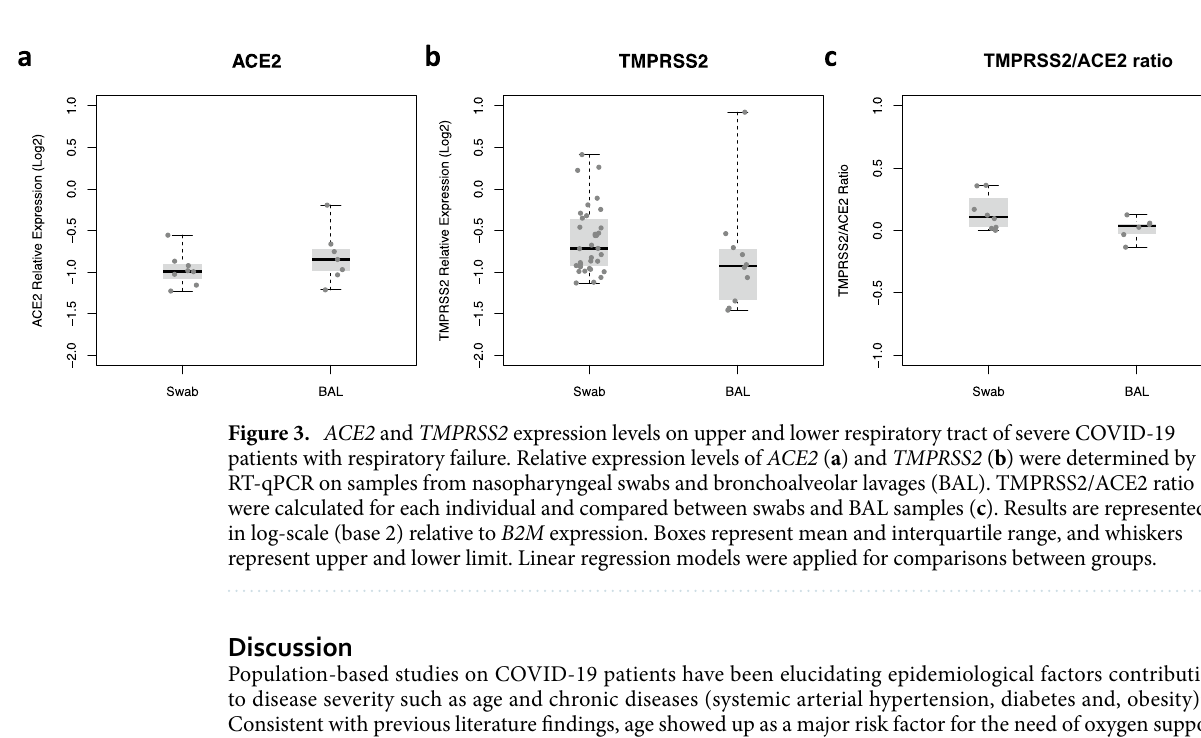
Table 2. Association between ACE2 and TMPRSS2 expression on nasopharynx and respiratory distress during COVID-19. *OR estimates adjusted for age, systemic arterial hypertension, diabetes and obesity. OR values represent an associated risk/protection according to an increase of 1 log of target’s expression relative to B2M gene. SD = standard deviation.